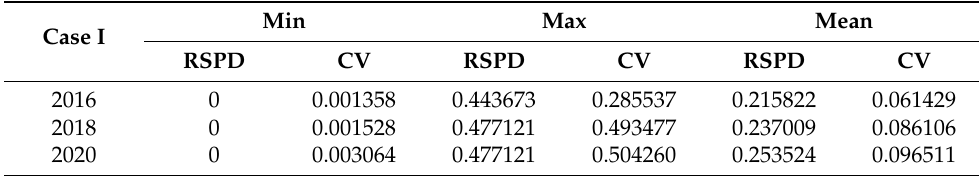
Table 2. Statistical analysis of RSPD and CV in Case I.